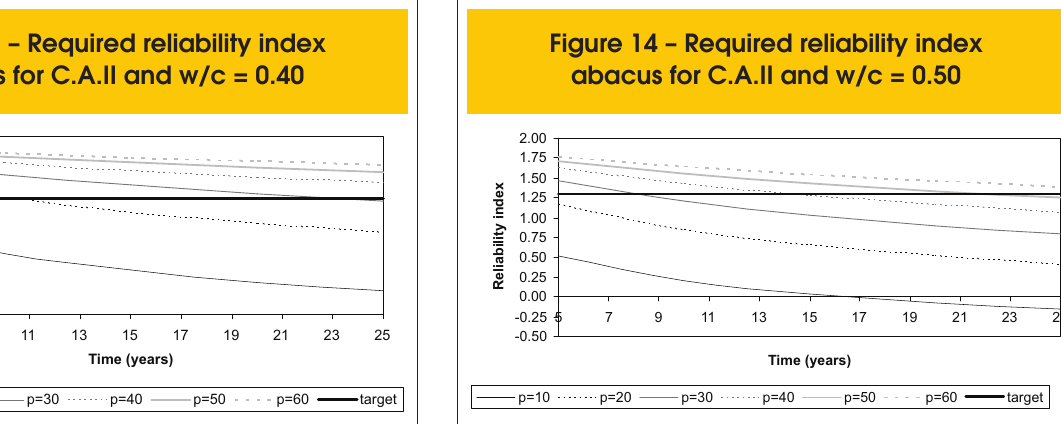
Figure 13 – Required reliability index abacus for C.A.II and w/c = 0.40